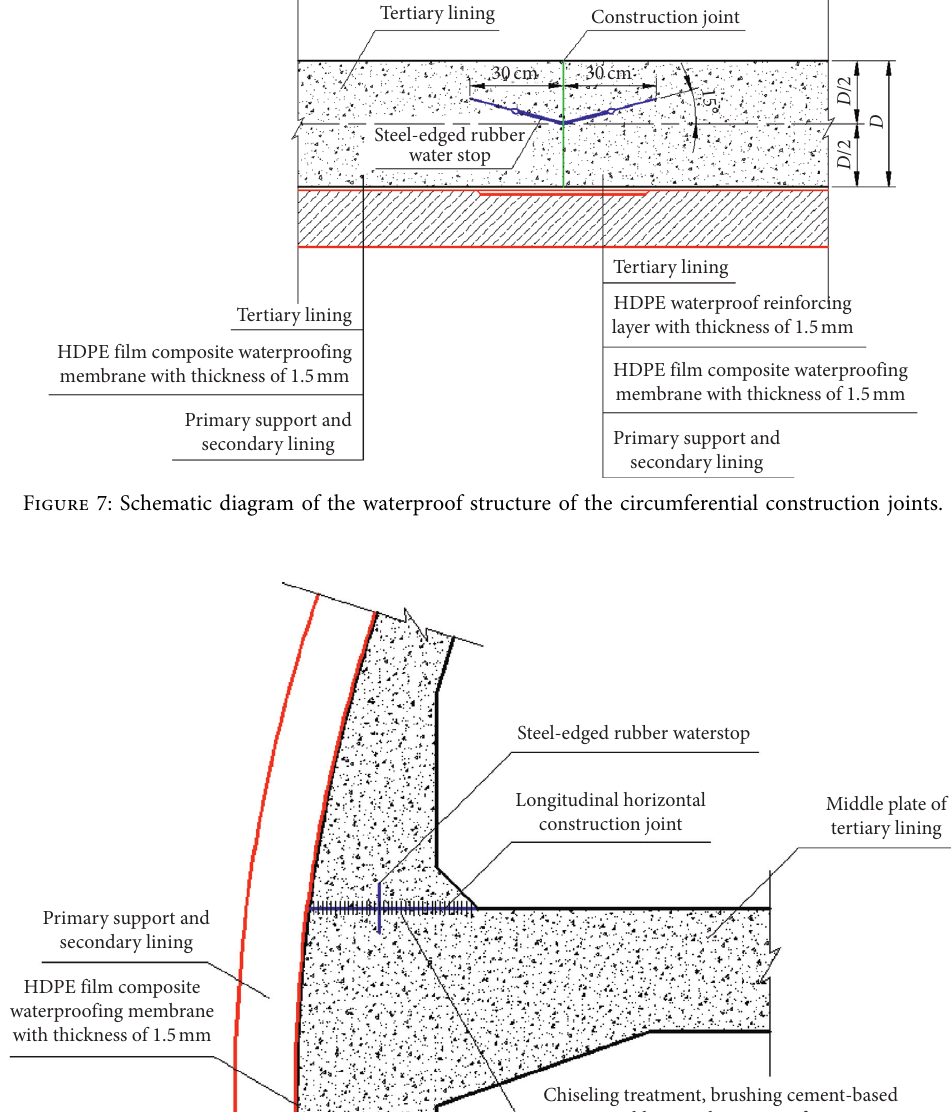
Primary support and secondary lining HDPE film composite waterproofing membrane with thickness of 1.5 mm